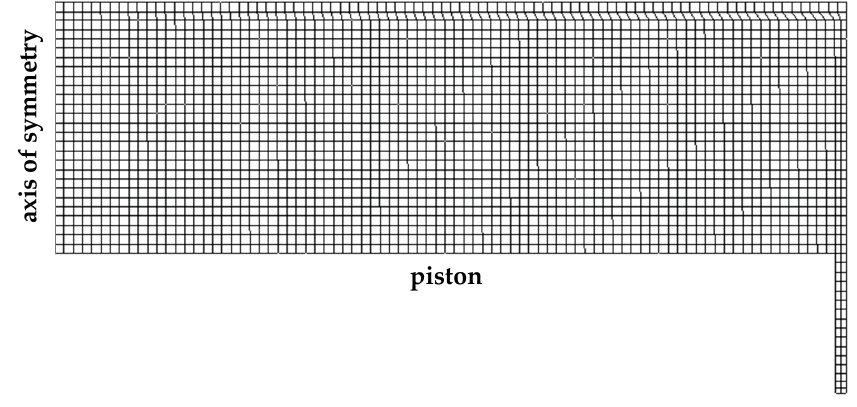
Figure 7. Computational grid for the engine with a flat piston at 30 CAD BTDC.